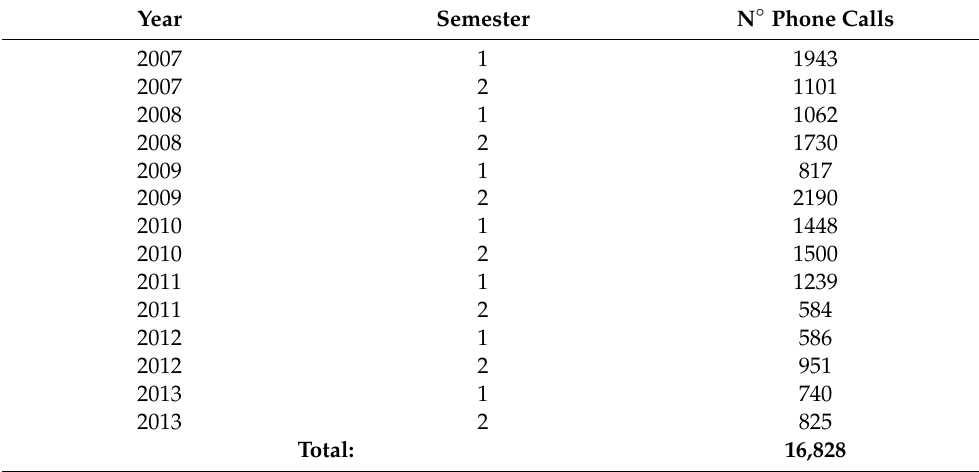
Table 3. Summary of phone calls received by the Emergency Service 112 of Castilla-La Mancha regarding